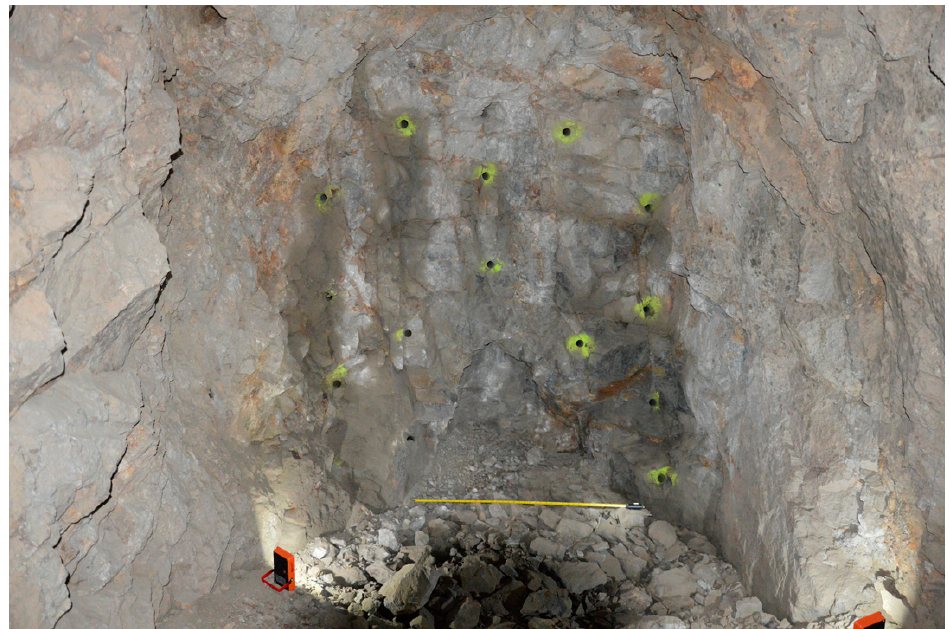
Figure A7. Cavity after detonation of hole with sequence number 6.